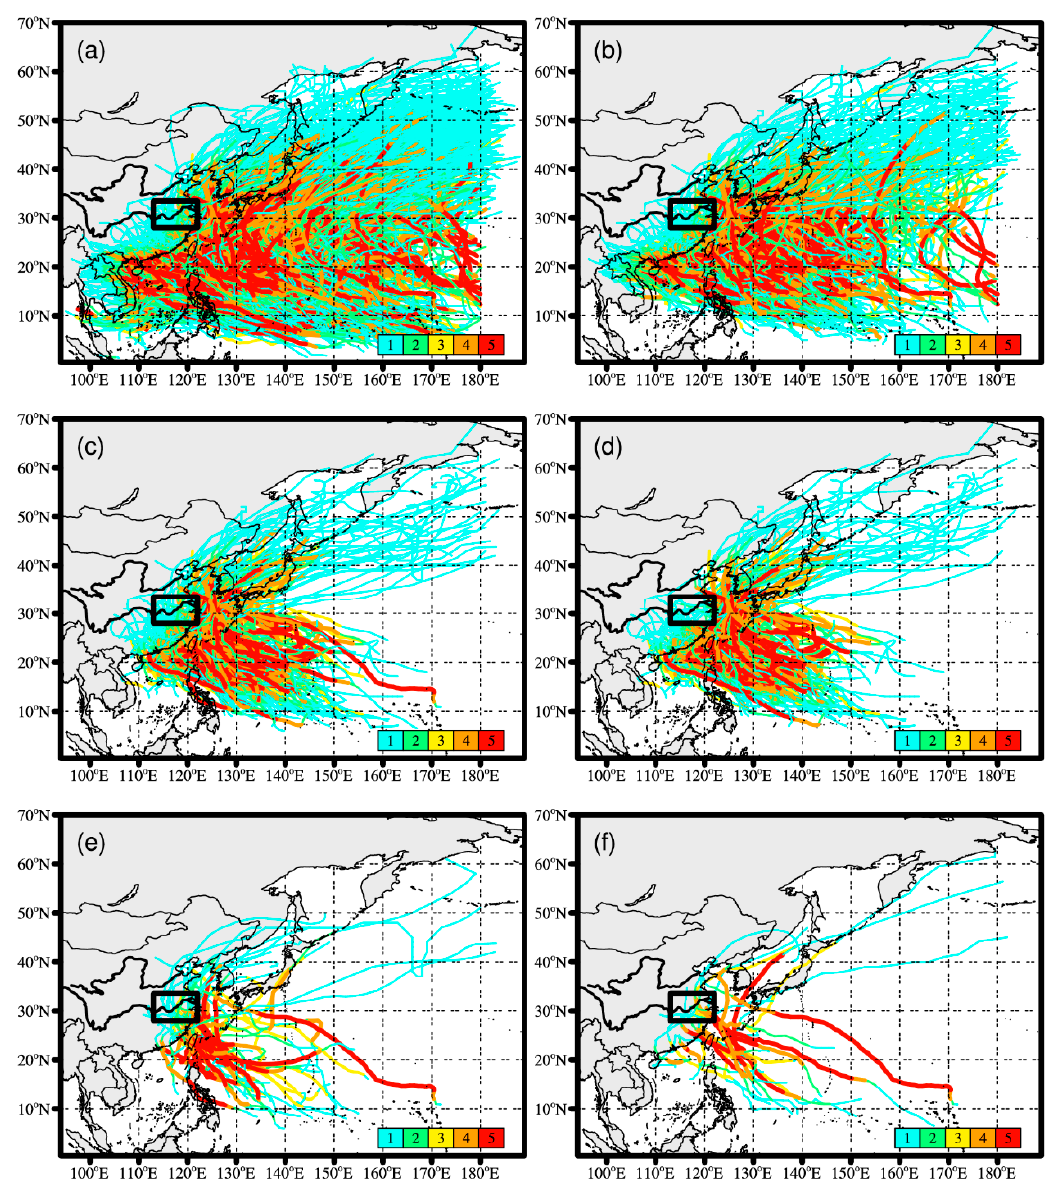
Figure 2. The observational TC tracks between 1961 and 2014. The color scales denote Saffir–Simpson hurricane wind scales. ( a ) All the annual TC tracks. ( b ) Summertime TC tracks. ( c ) All TC tracks that induce precipitation in summer. ( d ) The TC tracks that induce normal rainfall events in summer. ( e , f ) The TC tracks that induce 75th and 95th percentile precipitation events, respectively. The black rectangle denotes the middle–lower reaches of Yangtze River Basin (MLYRB) within the region 28°–33.5° N, 113°–122° E.